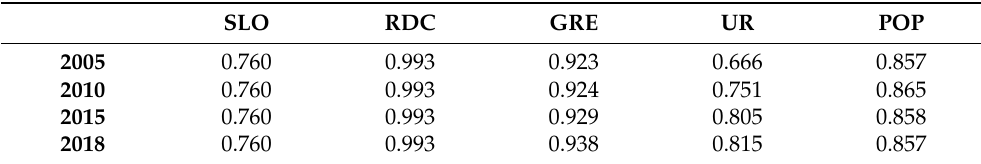
Table 4. Moran’s I for five factors in 2005, 2010, 2015, and 2018. SLO, slope; RDC, river distance accessibility; GRE, per capita green area; UR, the proportion of urban and rural human settlements; POP, population. SLO